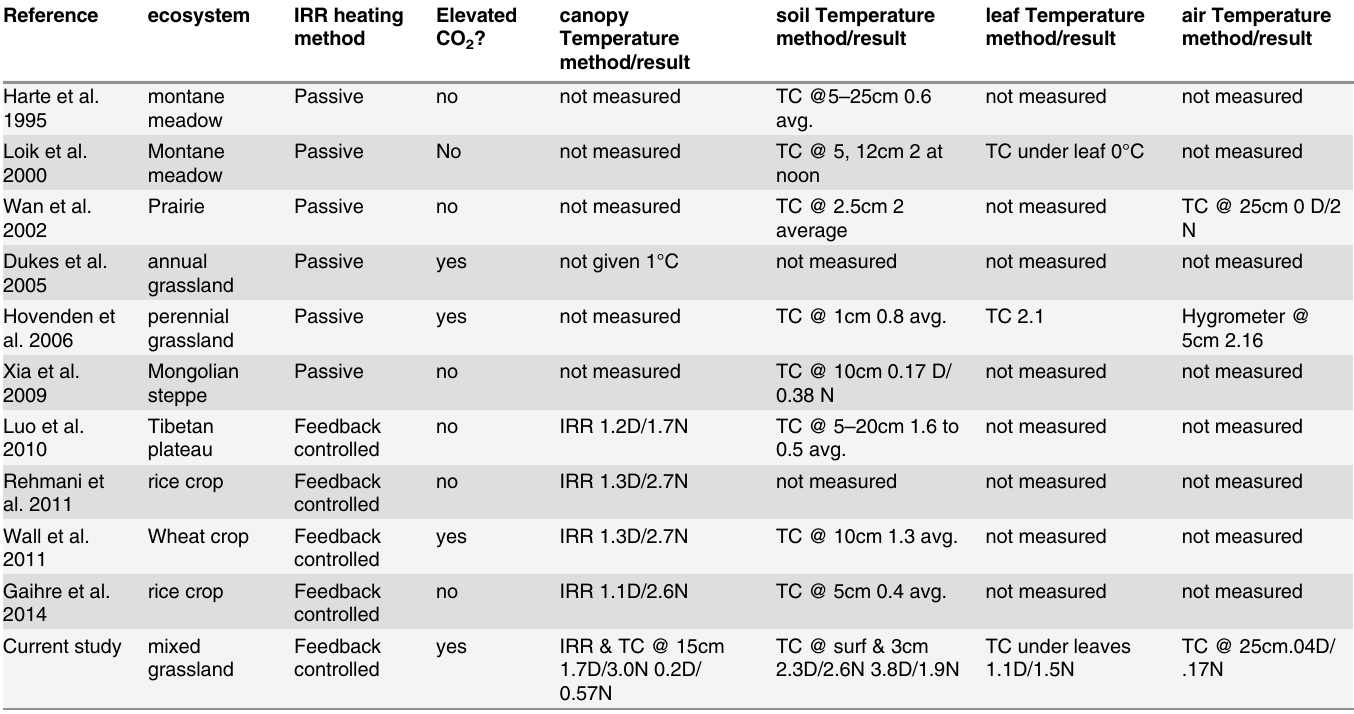
Table 3. Published fi eld infrared heater warming studies.